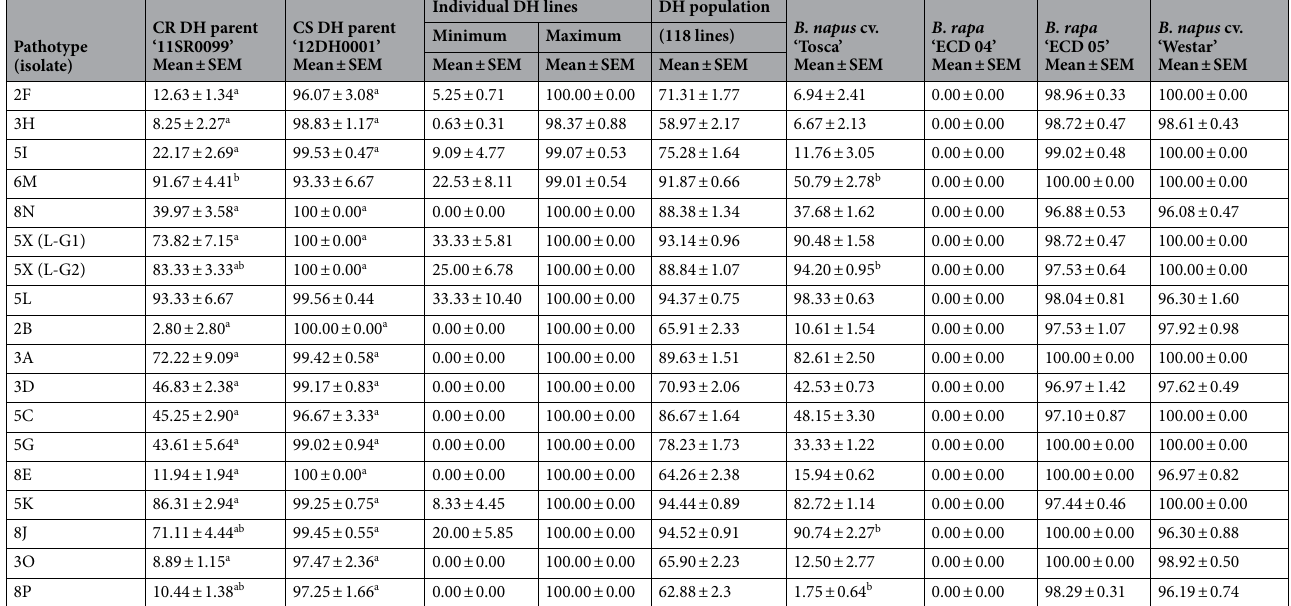
Table 1. Clubroot severity data for ‘11SR0099’ (clubroot-resistant doubled haploid (DH) parent), ‘12DH0001’ (clubroot-susceptible DH parent), DH individual lines and population, B. napus cv. ‘Tosca’, B. rapa subsp. rapifera European Clubroot Differential (ECD) 04, B. rapa var. pekinensis ECD 05, and the B. napus cv. ‘Westar’. a Clubroot severity (index of disease, ID %) was significantly ( P < 0.05) different in the resistant DH parent (‘11SR0099’) compared to the susceptible DH parent (‘12DH0001’). b Clubroot severity was significantly ( P < 0.05) different in the Brassica napus cv. ‘Tosca’ compared to the resistant DH parent